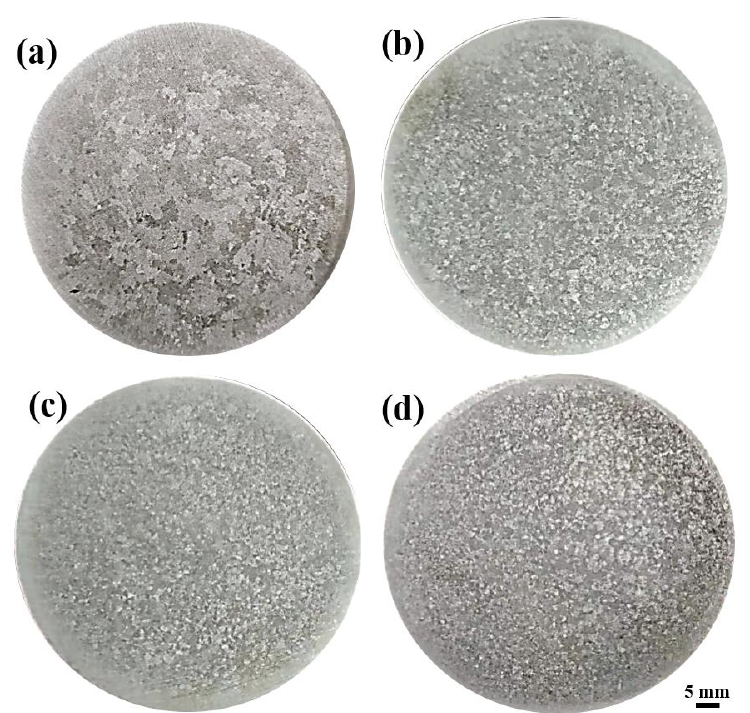
Figure 2. Grain image of Al-13Si-1Cu alloy with different addition amounts of Al-2Ti-0.5B-0.5C master alloy: ( a ) A1 alloy, ( b ) A2 alloy, ( c ) A3 alloy, ( d ) A4 alloy.